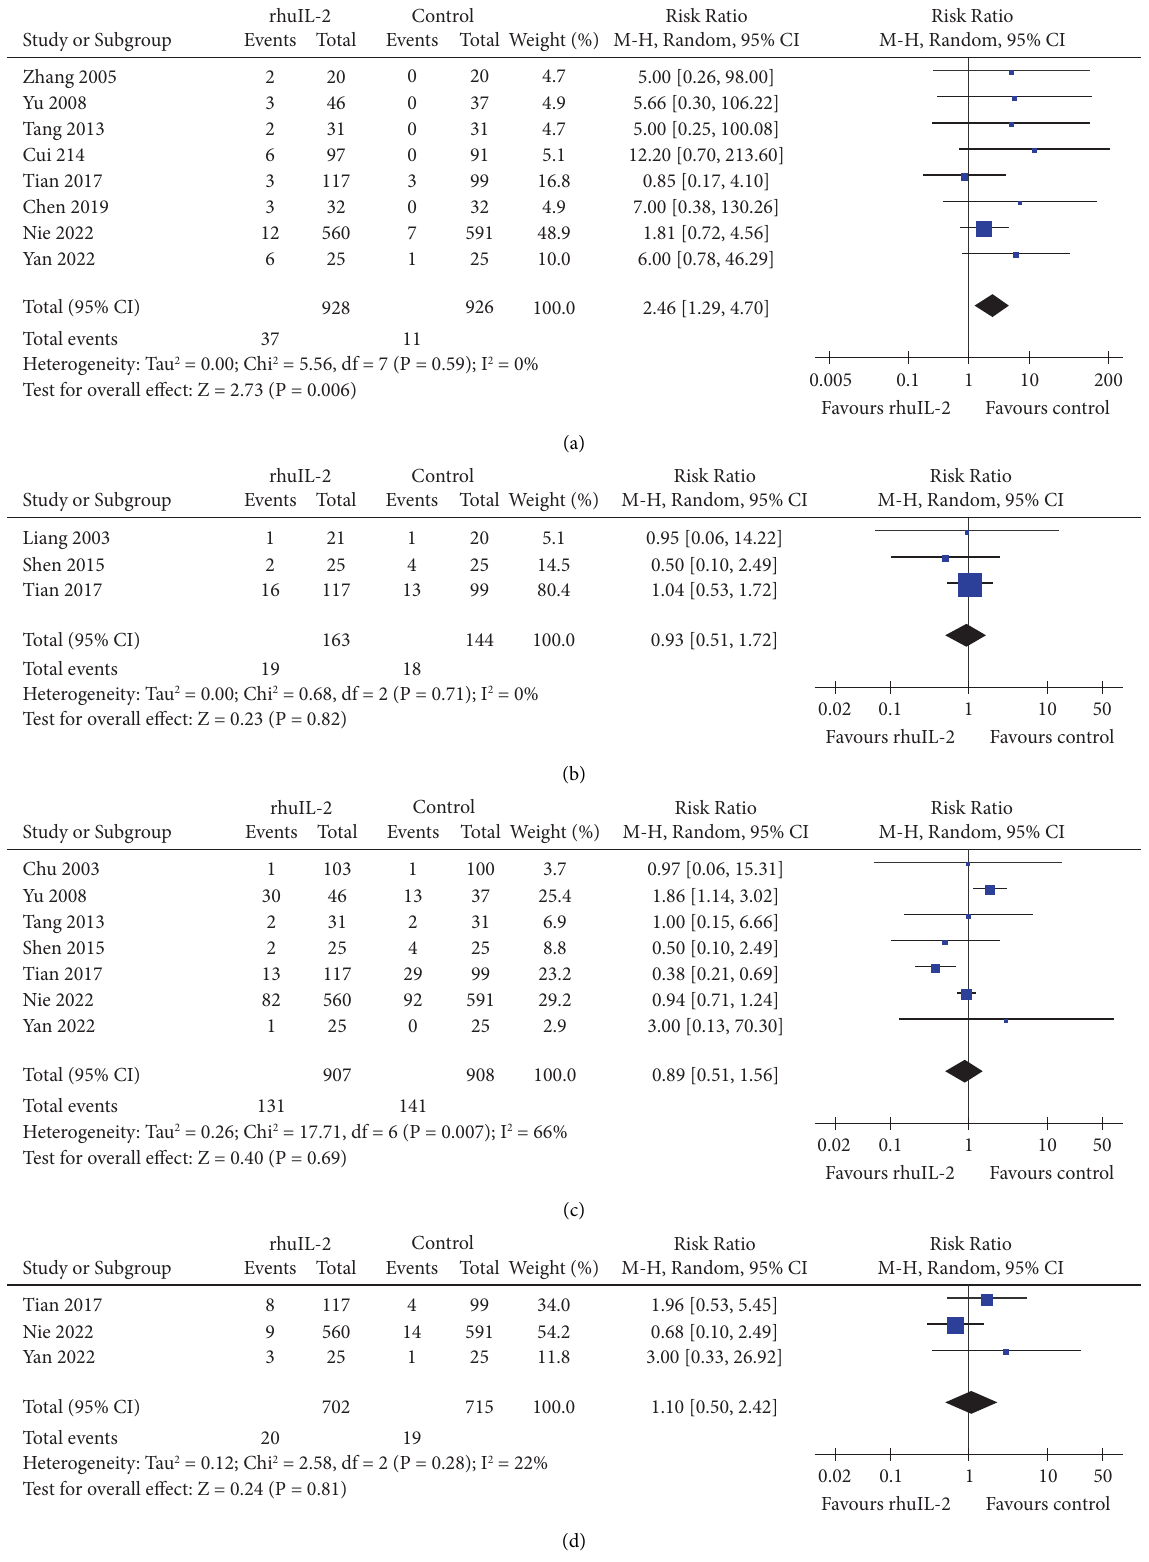
Heterogeneity: Tau 2 = 0.12; Chi 2 = 2.58, df = 2 (P = 0.28); I 2 = 22% Test for overall efect: Z = 0.24 (P = 0.81)